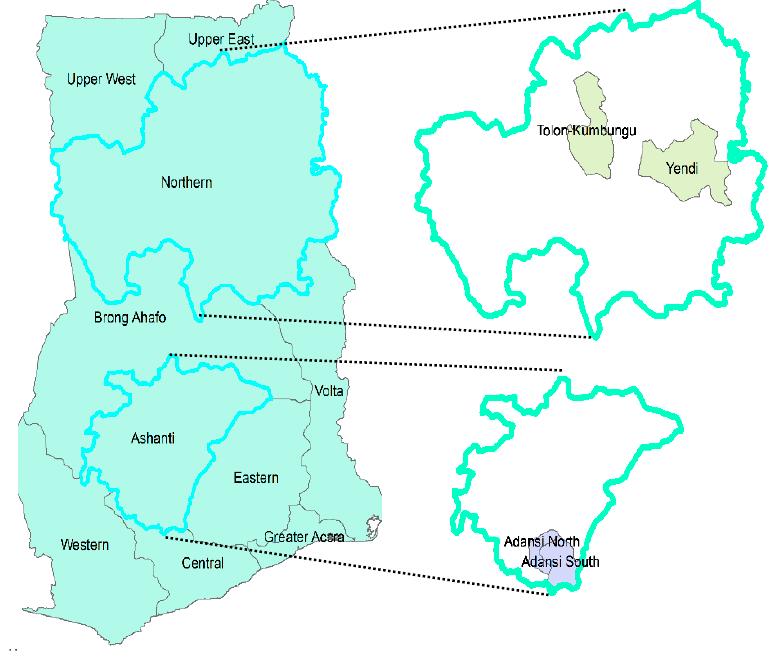
Figure 2. Map of the study area (reproduced from [47], following copyright regulation of Geofabrik GmbH and OpenStreetMap Contributors, 2018).